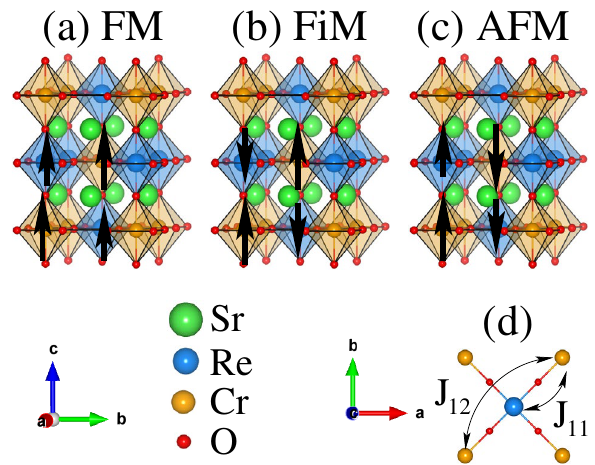
Figure 1. Schematic representation of the double perovskite structures of Sr 2 CrReO 6 in ( a ) ferromagnetic (FM), ( b ) ferrimagnetic (FiM), and ( c ) antiferromagnetic (AFM) ordering. The octahedral surroundings of the Cr and Re atoms are visualized in orange and blue colored polyhedron, respectively. ( d ) the top view in the ab -plane demonstrating the spin-coupling between Cr-Re ( J 11 ) via oxygen and indirect Cr-Cr ( J 12 ) atoms. The x , y , and z -axes are along the crystallographic a , b , and c -directions, respectively. The x and z -axis ( a and c -directions) are pointing towards the observer in ( a , b ) and ( c ),